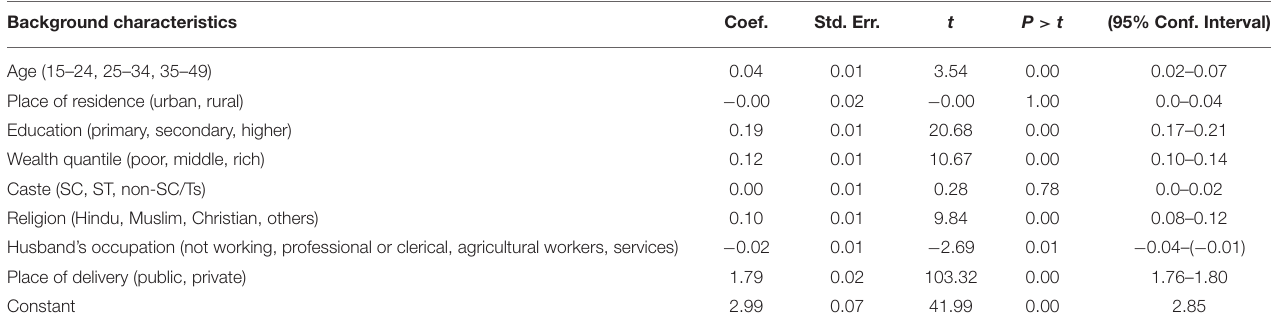
TABLE 3 | Regression coefficient and 95% CI of out-of-pocket expenditure (OOPE) (in rupees) of the most recent live birth among women aged 15–49 years according to background characteristics in India, the National Family Health Survey-4 (NFHS-4) (2015–2016). Background characteristics Coef. Std. Err.